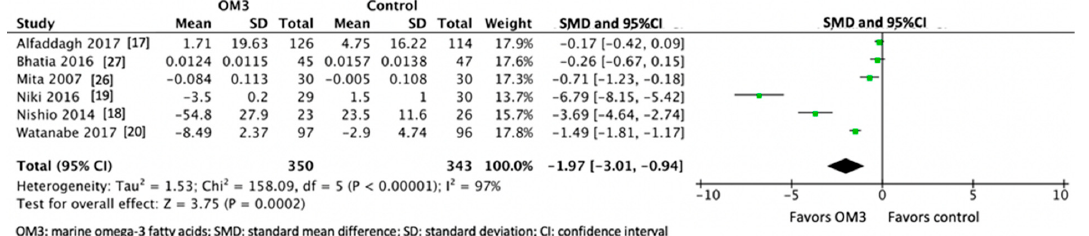
Figure 3. Sensitivity analysis after excluding the most and second most influential studies.